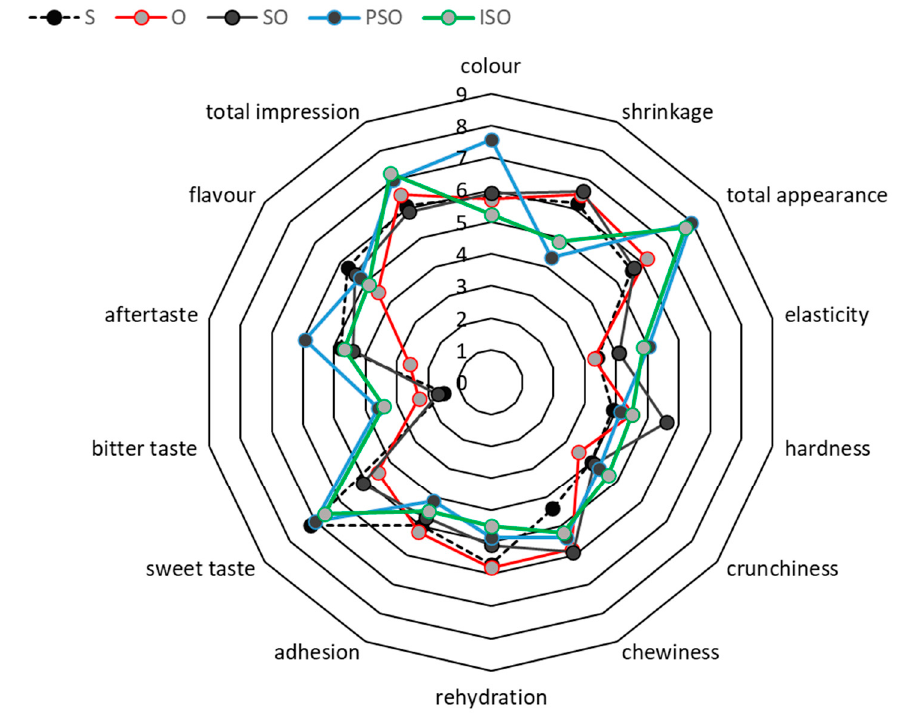
Figure 6. Sensory scores for the attributes on the hedonic scale [OD solute type: S, O, SO, PSO, ISO] at the optimum process conditions, as depicted n Table 4. Average scores (scale 1–9) for color (axis 1), shrinkage (axis 2), total appearance (axis 3), firmness (axis 4), adhesiveness (axis 5), springiness (axis 6), chewiness (axis 7), total texture (axis 8), sweet taste (axis 9), bitter taste (axis 10), aftertaste (axis 11), total flavor/taste (axis 12) and total impression (axis 13).